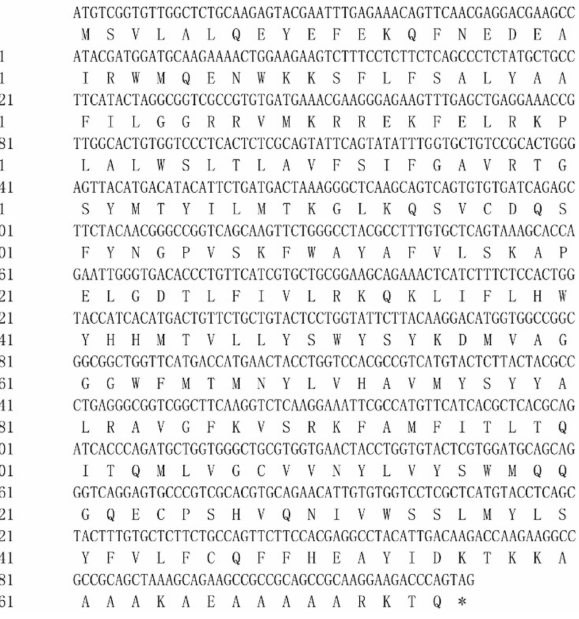
Figure 1. Nucleotide and deduced amino acid sequences of the elongation of very long-chain fatty acids protein 6 (Elovl6) in rainbow trout. * Represents the stop codon.